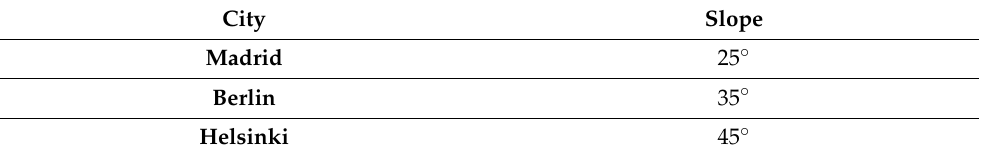
Figure A2. Incident angle modifiers (IAMs) for the collectors chosen. For the locations considered, the optimal slopes for the installation of the solar collec- tors are reported in Table A2 [49]. Table A2. Slopes for the installation of the solar collectors in the cities